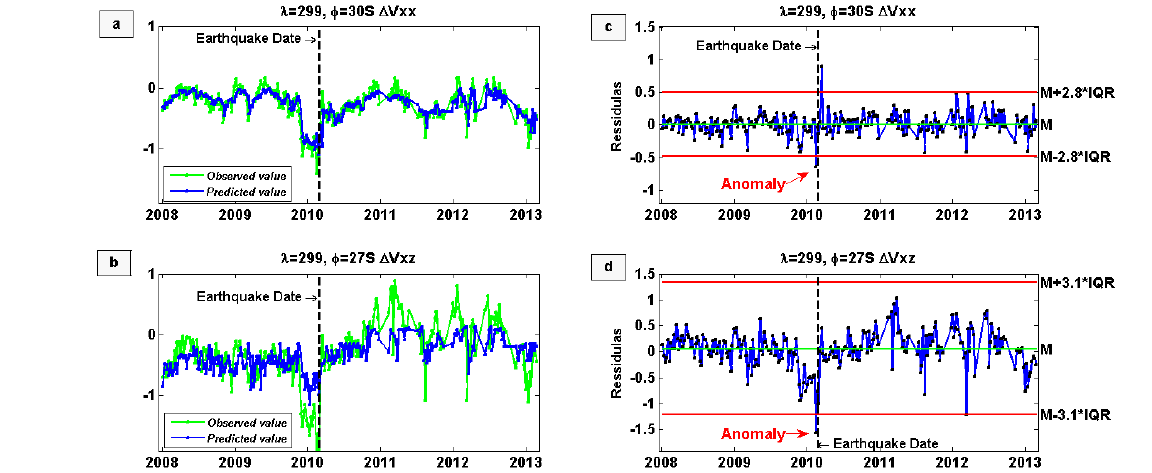
Figure 6. (a) and (b) variations of the observed (green curve) and predicted (blue curve) gravitational gradient obtained from NARX method. (c) and (d) Variations of the differences between the observed and the predicted values of ∞ V